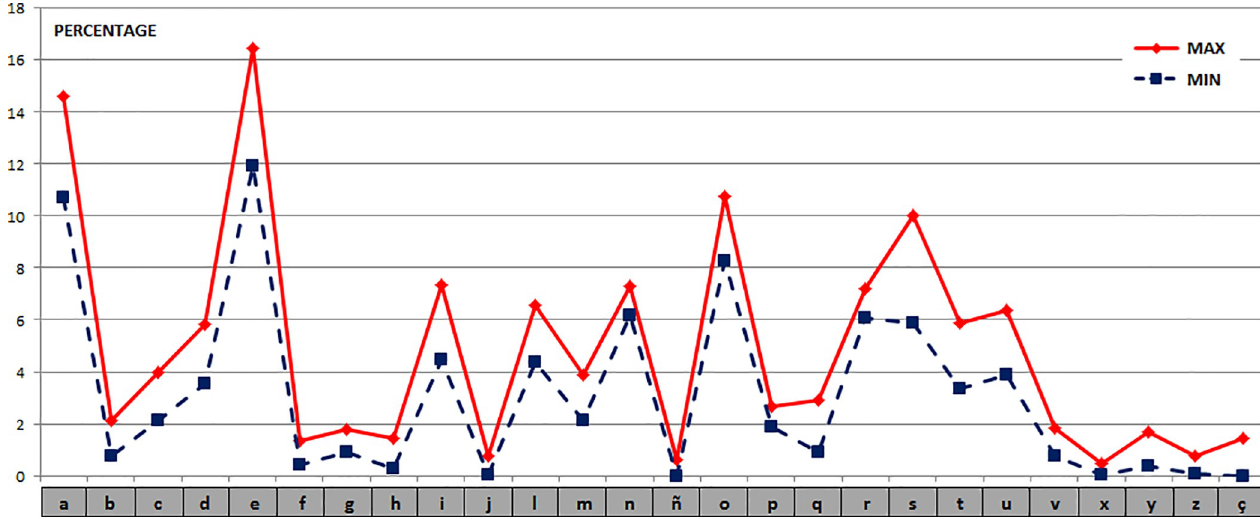
Fig 8. Frequency values of the graphemic units of the 10 Spanish or Castilian texts.